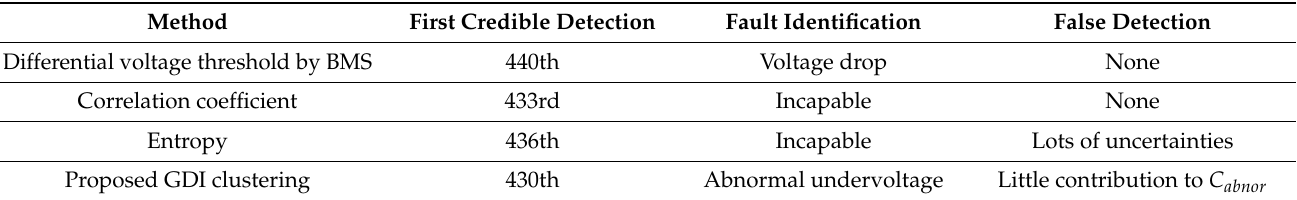
Table 2. Performance of the Methods in Case